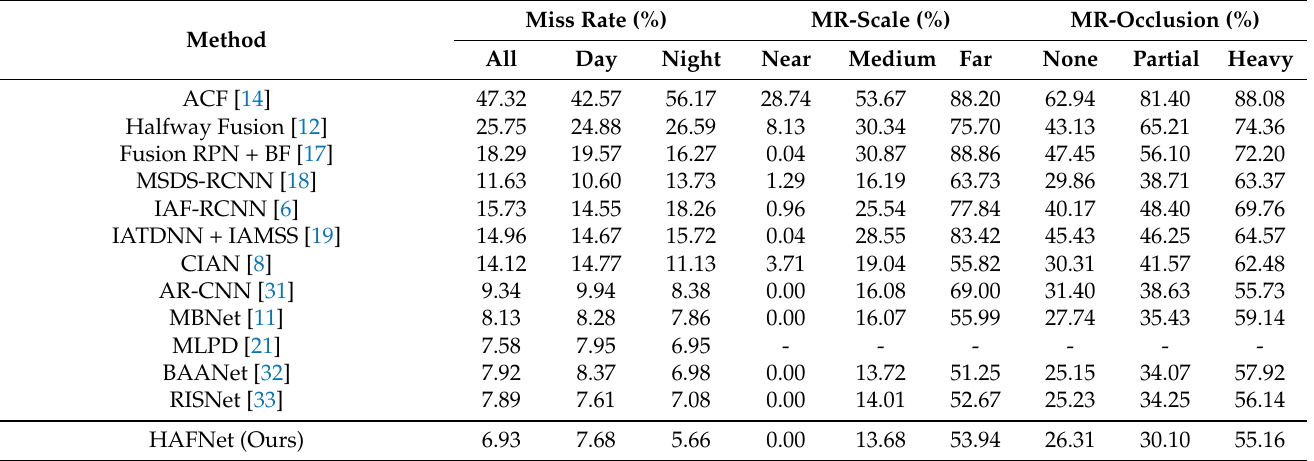
Table 1. Miss rate comparison on nine subsets of the KAIST dataset [16]. Sca. and Occ. denote scale and occlusion,